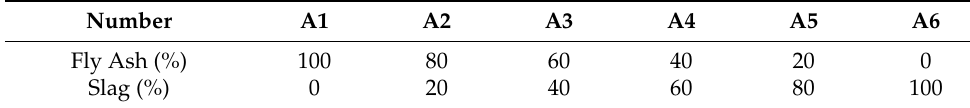
Table 4. Designations of SL/FA.